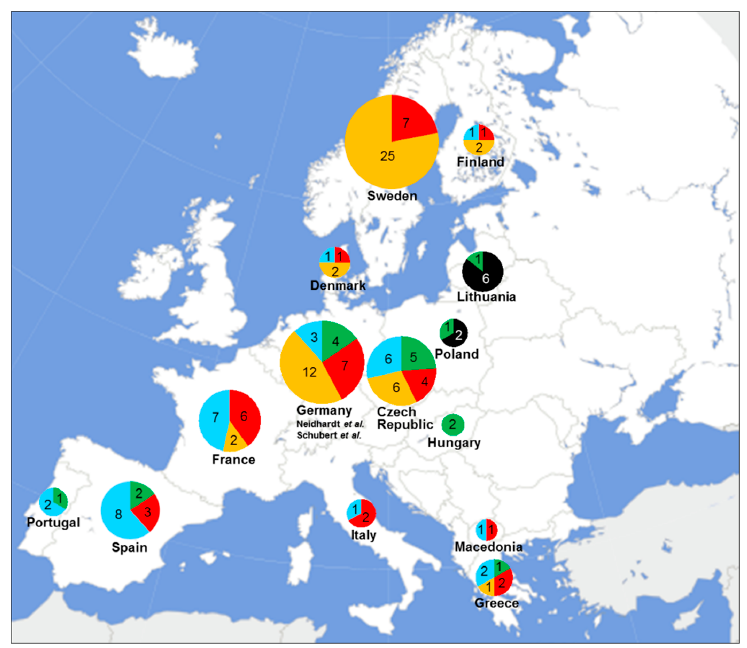
Figure 1. Distribution of the common and rare FANCM PTVs found in the 114 European female breast cancer probands. The common PTVs p.Gln498Thrfs*7, p.Arg658*, p.Gln1701*, and p.Arg1931* are indicated in black, green, orange, and red, respectively; the rare PTVs are indicated in light blue. Numbers of PTV carriers are reported according to their country of origin. The 26 PTV carriers from Germany are derived from previously published studies (Neidhardt et al., 21 probands [9]; Schubert et al., 5 probands [13]). Table 2. Twenty-nine breast cancer probands who carry one of the 23 rare FANCM PTVs.